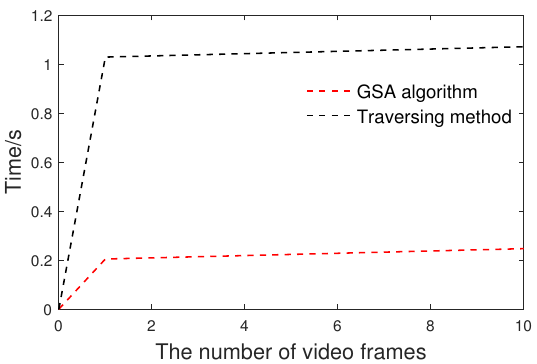
Figure 18. Autonomous underwater vehicle operating system.